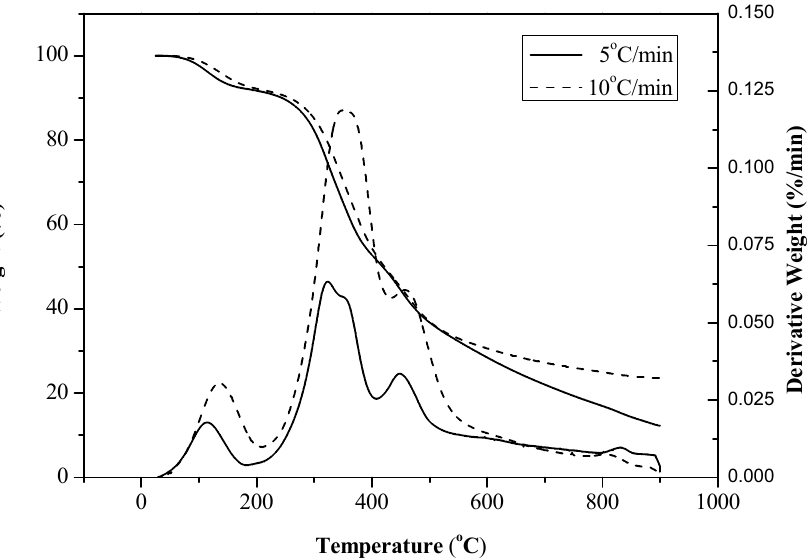
Figure 1. Thermogravimetric analysis/derivative thermogravimetry (TGA/DTG) curves of the Sapindus pericarp (SP) extraction residue at two heating rates (5 and 10 °C/min).